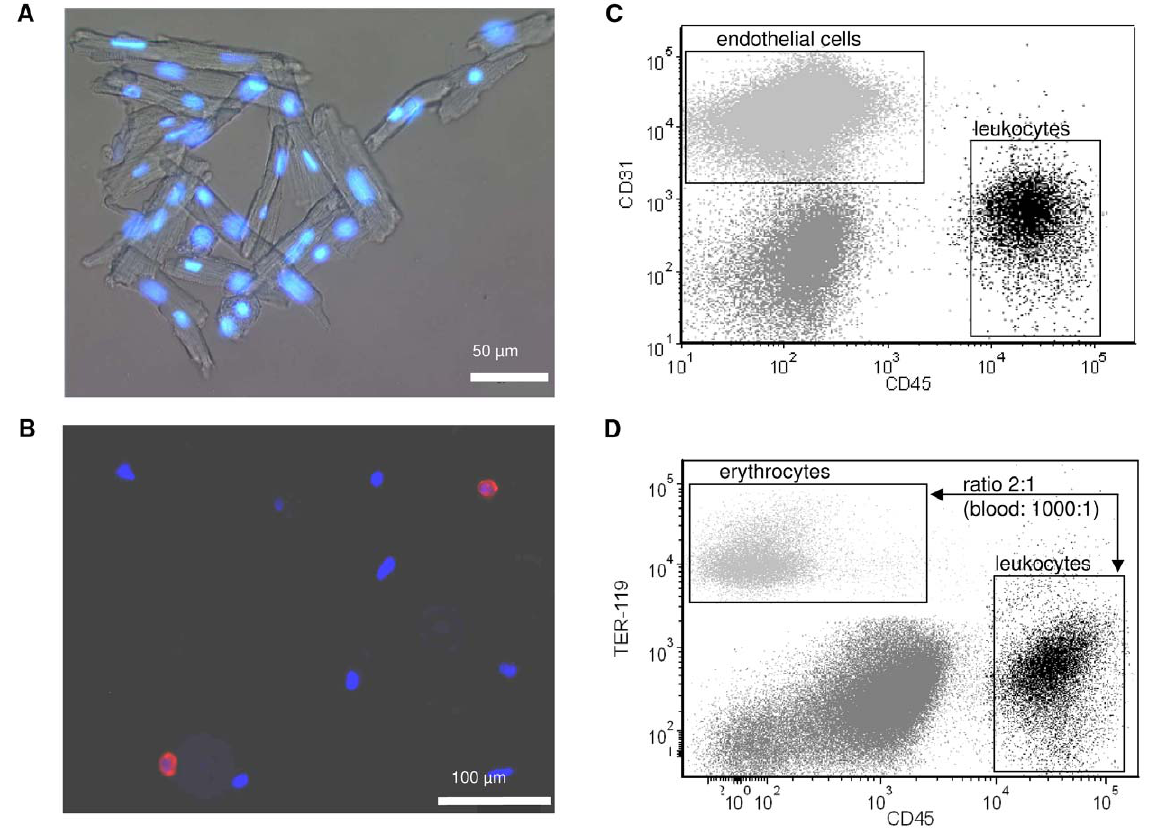
Figure 1. Analysis of the different cell fractions present within the unstressed heart. Fluorescence microscopy of intact murine cardiomyocytes ( A ) and non-cardiomyocytes ( B ) extracted from the murine heart. Red=CD45 + cells (fluorescence microscopy). Blue=nuclear stain with DAPI. C : Representative flow cytometry plot of non-cardiomyocytes. Black=CD45 + cells (lower right), light grey=endothelial cells (CD31 + , upper left) and dark grey=CD31 2 CD45 2 (lower left). D : Representative Ter-119/CD45 plot of non-cardiomyocytes to derive the ratio of erythrocytes to leukocytes in myocardial tissue. Assuming a ratio of erythrocytes/leukocytes in peripheral blood to be 1000:1, contamination of blood derived leukocytes was calculated to be , 0.2% (n=5).